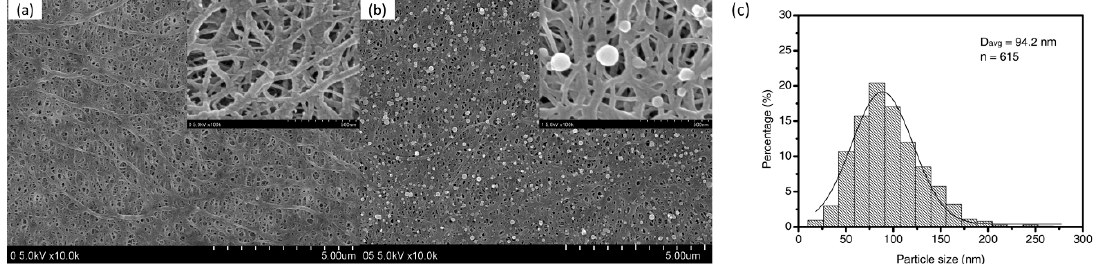
Figure 1. ( a ) Scanning electron microscopy (SEM) and high magnification (inset) images of bare polyethylene (PE); ( b ) SEM and high magnification (inset) images of the nanoparticulate-coated PE separator; ( c ) size range of the nanoparticulate on PE surface in ( b